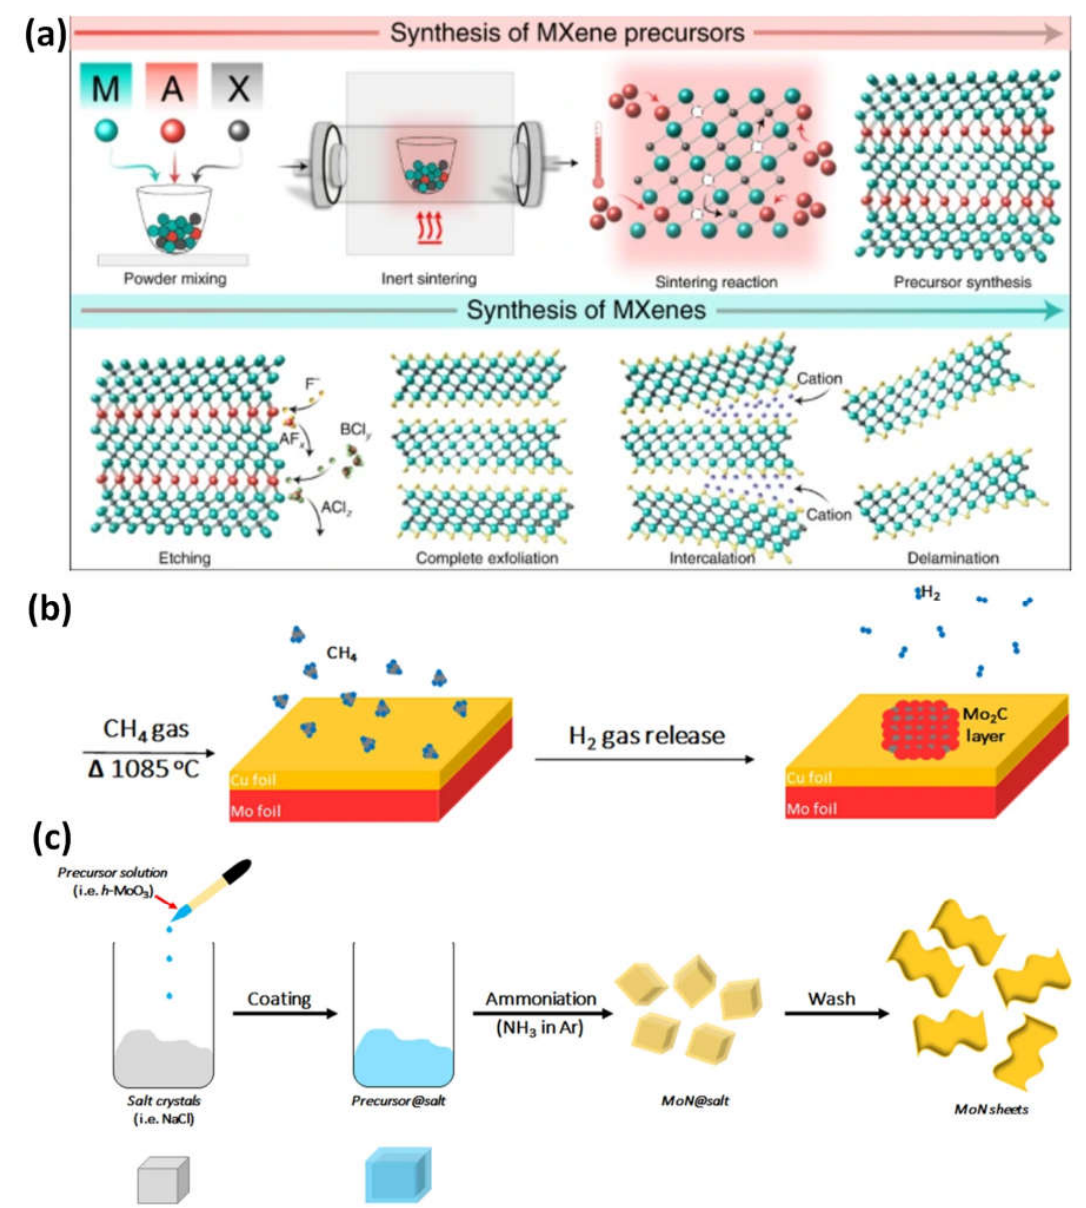
Figure 2. ( a ) Steps in the synthesis of MXene nanomaterials by top-down method from precursor to etching; bottom-up techniques are shown schematically in ( b ) chemical vapor deposition of Mo and C to generate a thin film of Mo 2 C in a gas chamber and ( c ) the synthesis of MoN nanosheets using a salt template. Reproduced with permission from references [18,26,27].